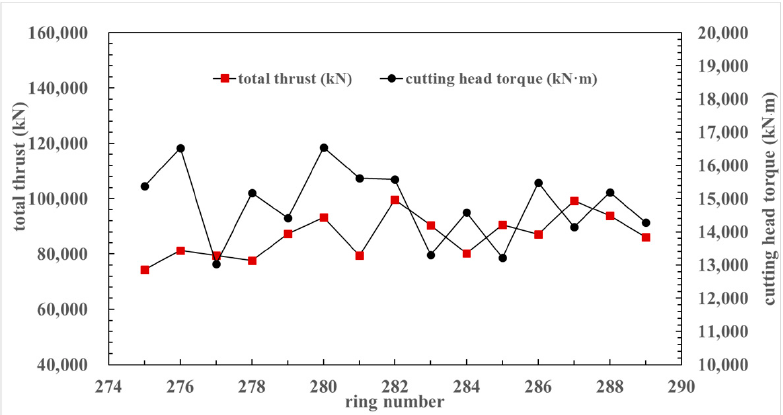
Figure 17. Changes of total thrust and cutting head torque of the machine at the Wuhan Metro Line 8 Yangtze River Crossing tunnel construction.